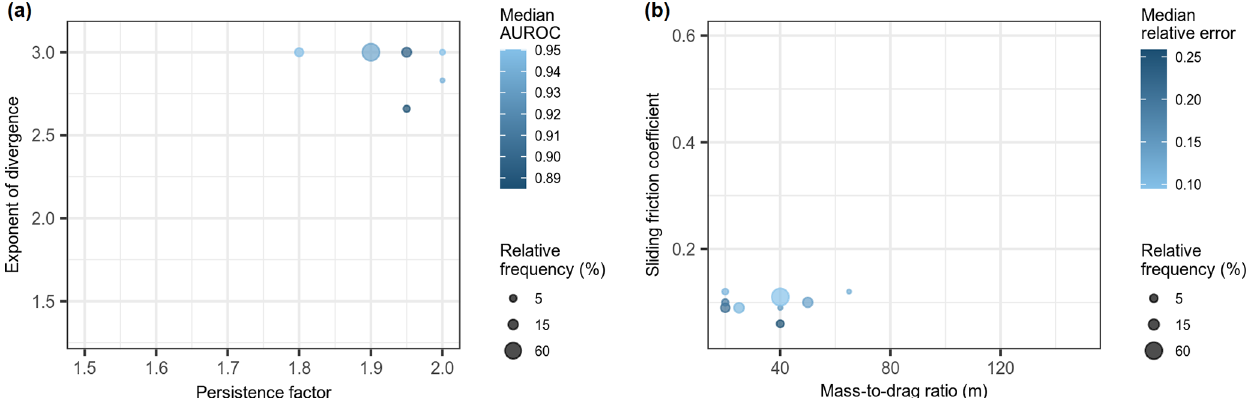
Figure 7. Model performance and frequency of optimal parameters for the runout path (a ; given an optimized slope threshold of 40 ) and runout-distance models (b) estimated using 1000 repetitions of 5-fold spatial cross-validation. Relative frequency is the percentage of all repeated spatial-cross-validation iterations where a given parameter combination was optimal.